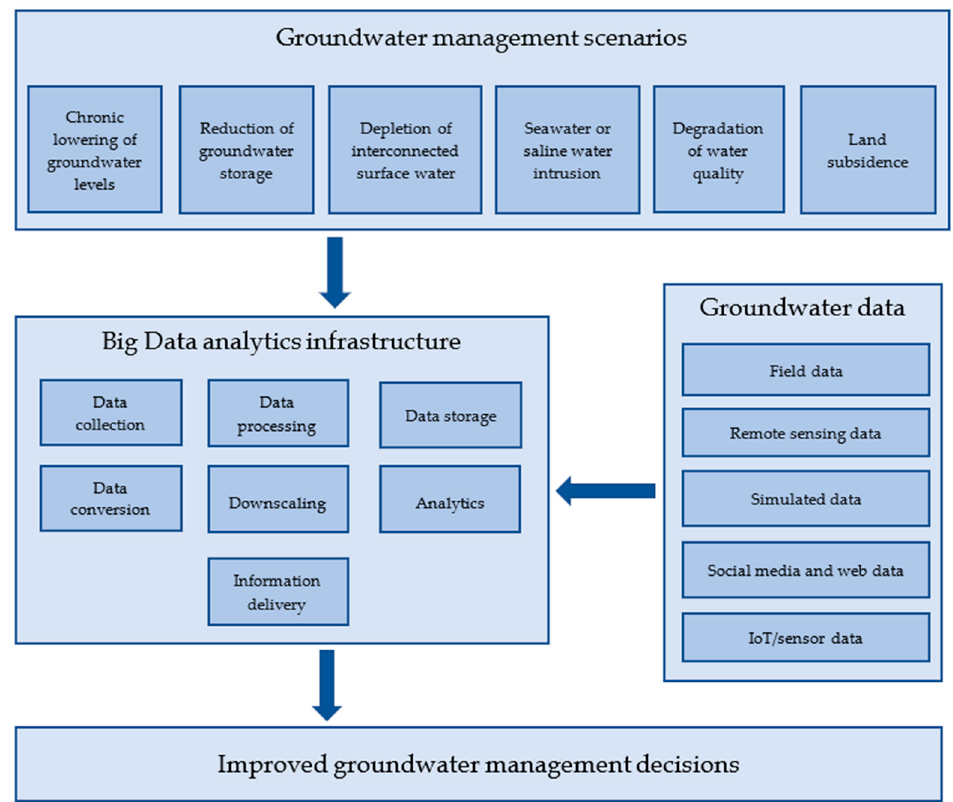
Figure 3. Conceptual framework for SADC groundwater management using big data analytics.